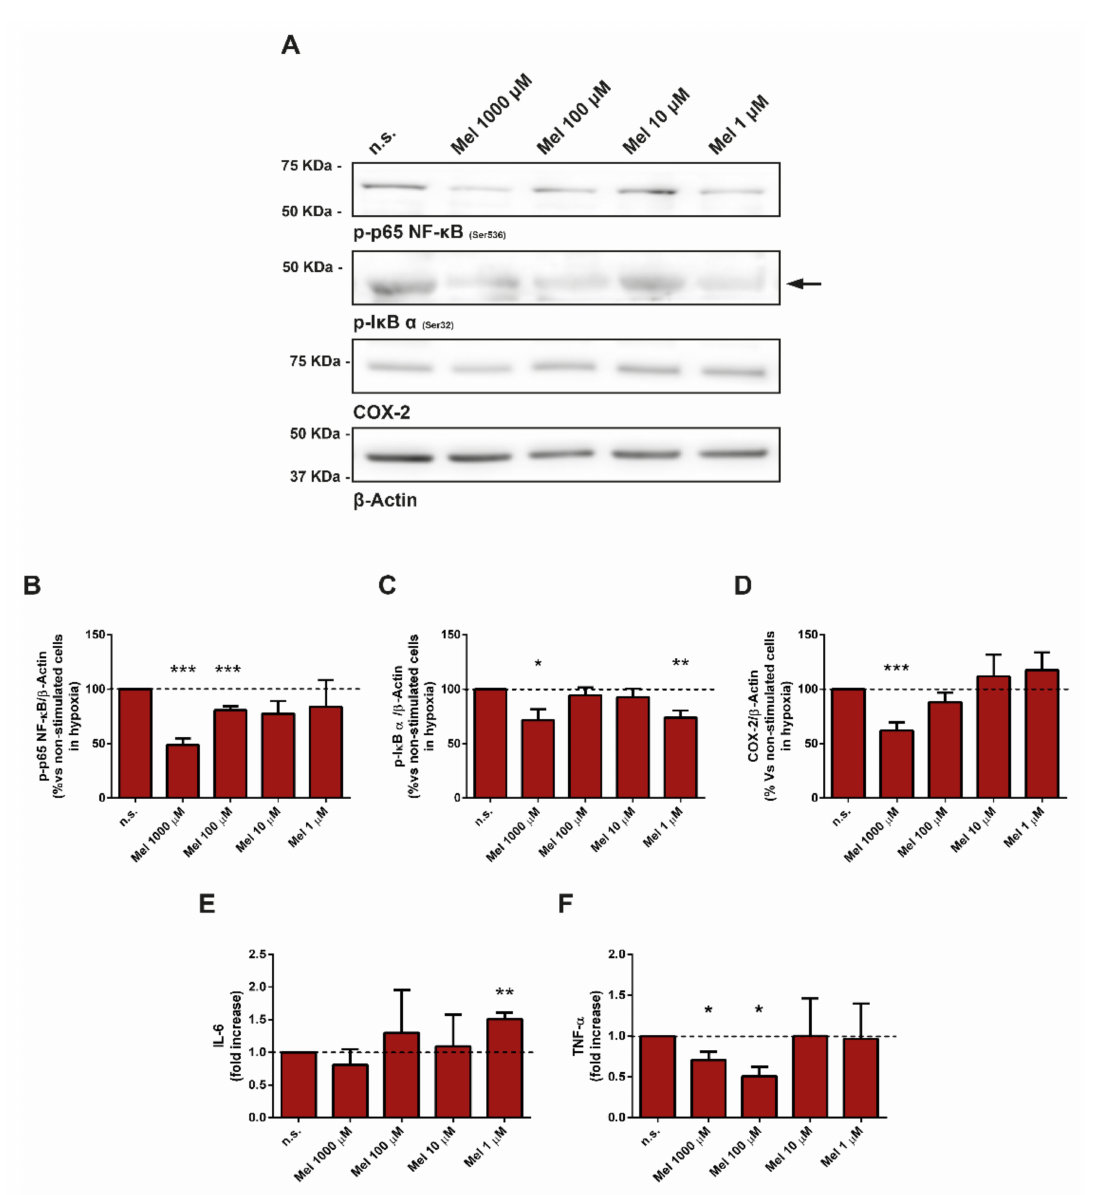
Figure 7. Effect of melatonin on major regulators of inflammation. PSC were incubated with melatonin (1000 µ M, 100 µ M, 10 µ M, or 1 µ M) for 4 h under hypoxia. ( A ) Blots showing the effect of melatonin on the phosphorylation state of NF-kB and of I κ B α . The expression of COX-2 also was analyzed by Western blotting. The levels of β -actin were employed as controls to ensure equal loading of proteins. The arrow indicates the specific band of I κ B α . ( B , C ) The bars show the quantification of protein phosphorylation. ( D ) The bars show the quantification of COX-2 detection. Results are the mean ± S.E.M. of normalized values, expressed as % with respect to non-treated cells. Four independent experiments were carried out. ( E , F ) RT-qPCR analysis was used to detect the expression of interleuquin-6 (IL-6) and of tumor necrosis factor- α (TNF- α ). The bars show the fold increase of mRNA levels ± S.E.M. of each protein relative to non-treated cells (incubated under hypoxia, but in the absence of melatonin). Three different preparations were used. A horizontal dashed line represents the value observed in non-treated cells (incubated under hypoxia but in the absence of melatonin) (n.s., non-treated cells; Mel, melatonin; *, p < 0.05; **, p < 0.01; and ***, p < 0.001 vs. non-treated cells in